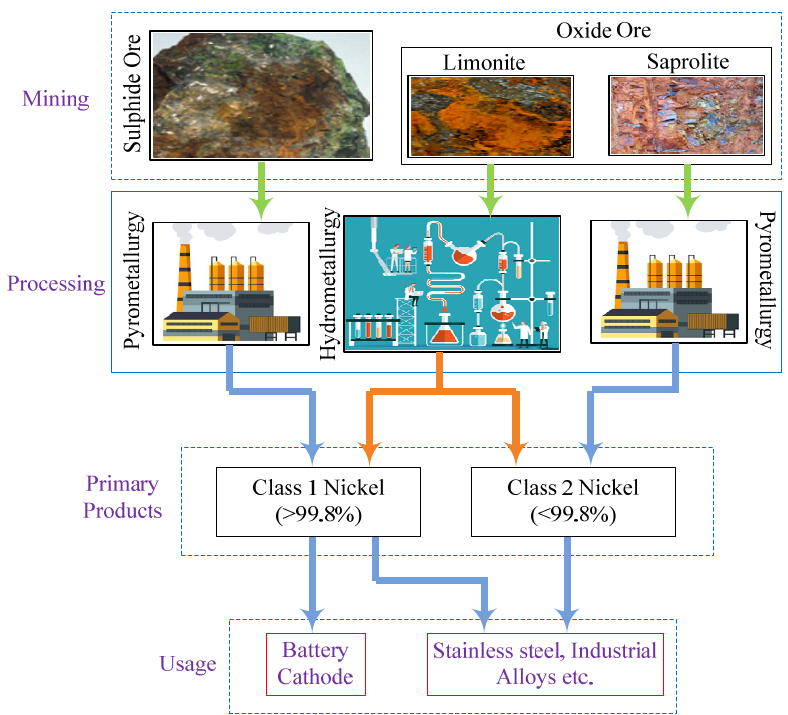
Figure 11. Nickel supply chain.